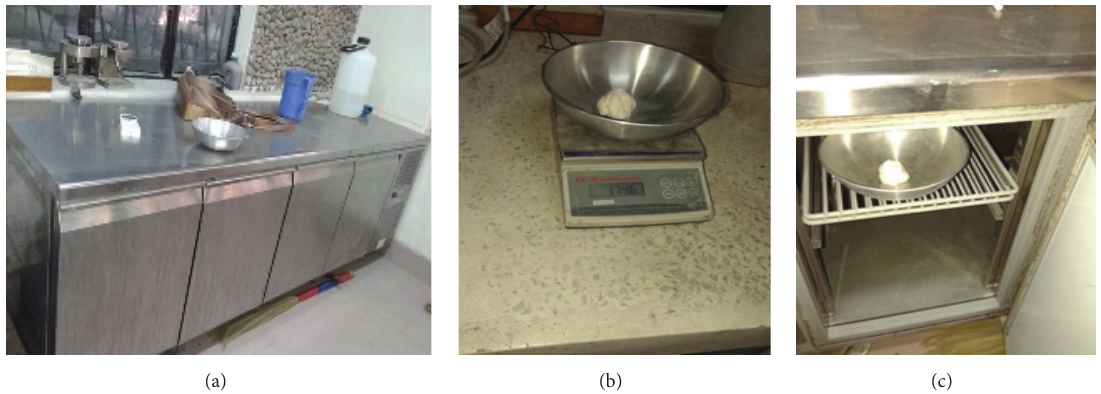
Figure 4: Desorption test: (a) dehumidifier; (b) weighting of SAP; (c) placing SAP in dehumidifier.